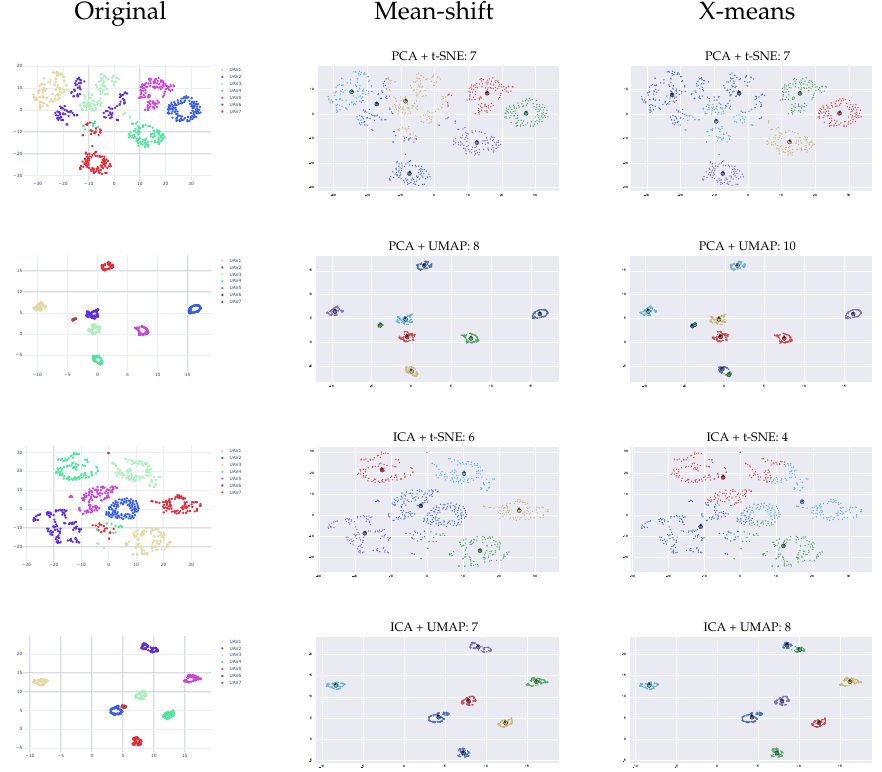
Figure 21. Clustering results using CWT and various dimension reduction